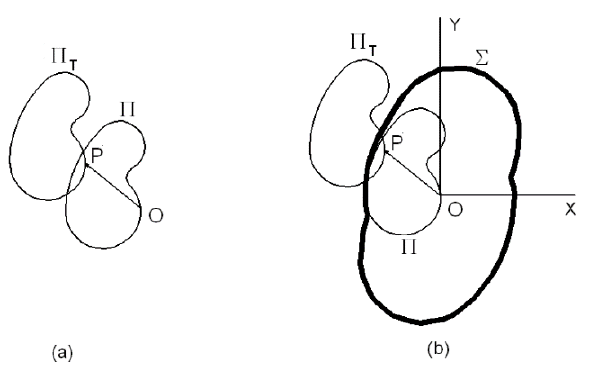
→ Π and Π OP is included in Σ . T intersect,